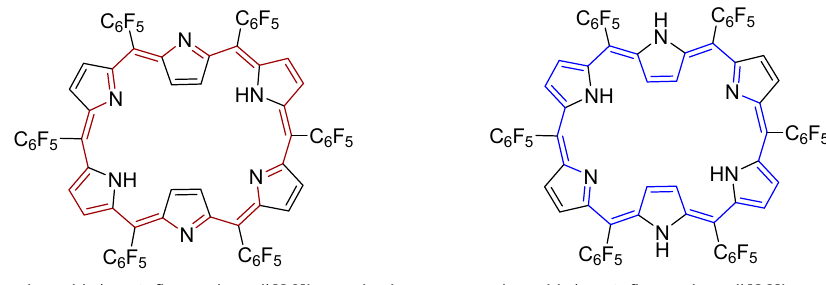
Figure 4. meso -Hexakis(pentafluorophenyl)hexaphyrins [69].